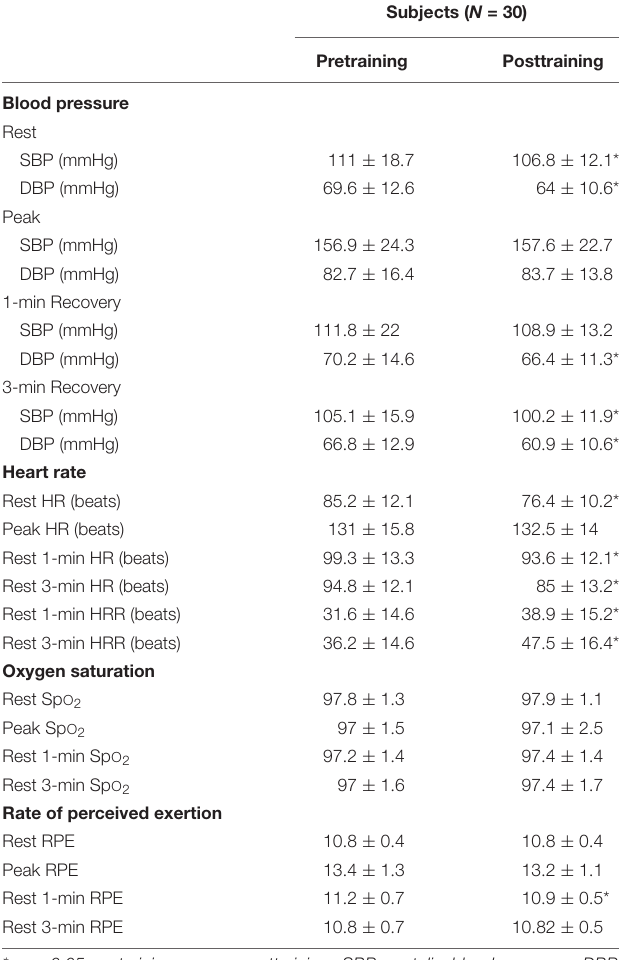
TABLE 2 | Blood pressure, heart rate, oxygen saturation, and rate of perceived exertion at pretraining/posttraining.